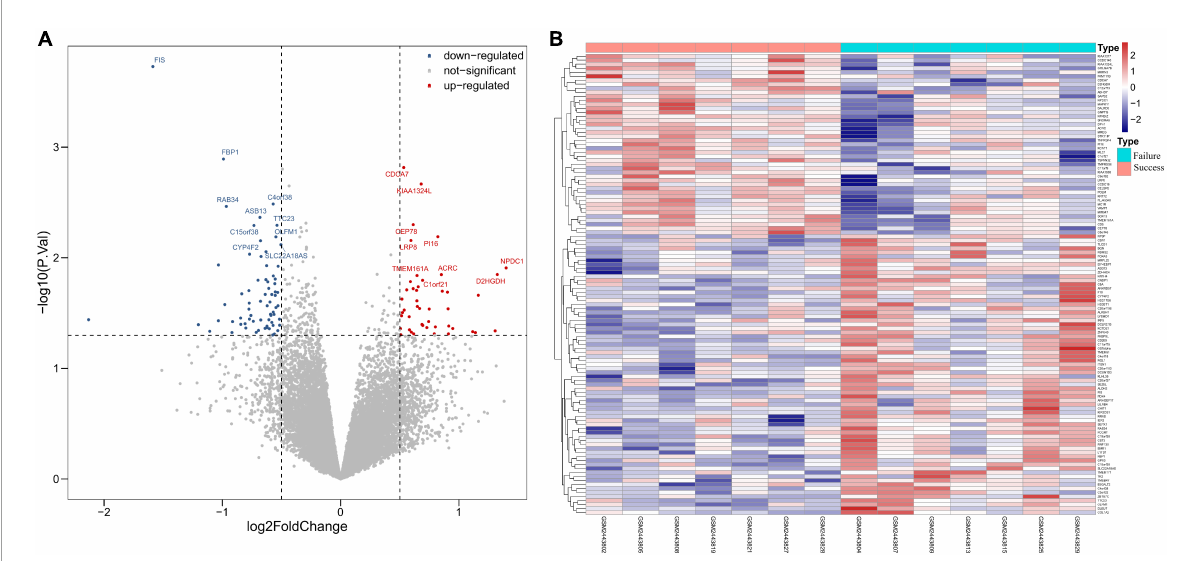
FIGURE1 Analysis of programmed cell death (PCD)-related genes in extracorporeal membrane oxygenation (ECMO) treatment for acute myocardial infarction (AMI). (A) Volcano plot representing PCD-related genes. In the volcano plots, the red points show upregulated genes (log 2 FC ≥ 0.5 and P -value < 0.05), whereas the blue points represent downregulated genes. (B) Heatmap of PCD-related differentially expressed genes. The color intensity (from red to blue) suggests higher to lower